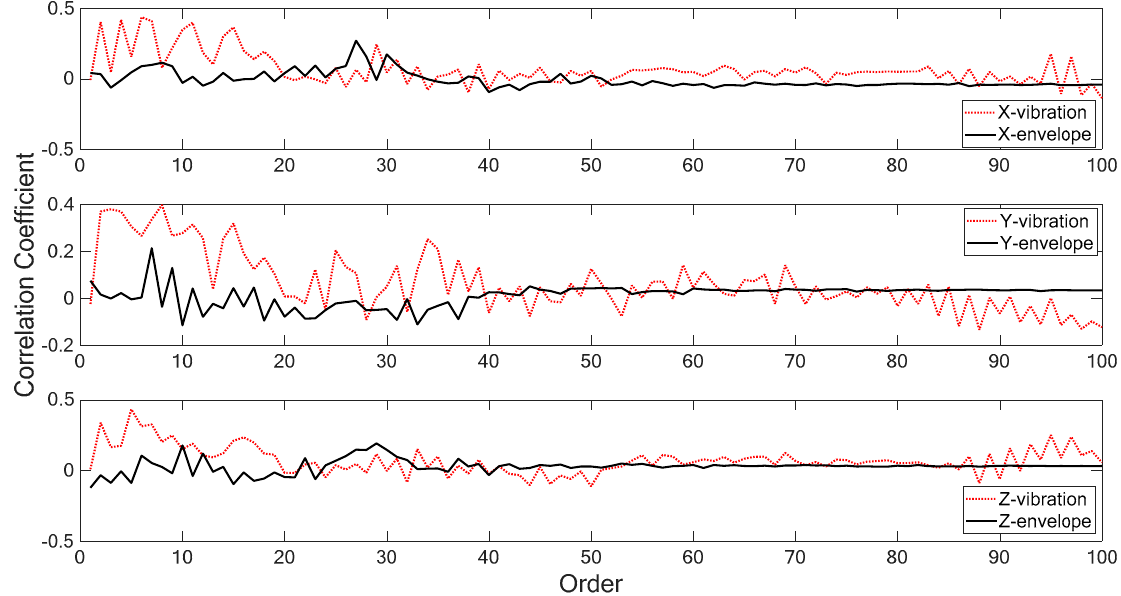
Figure 5. Correlation coefficients among Ra values and power spectrum densities of spindle vibration signals as well as their corresponding envelopes in three directions.